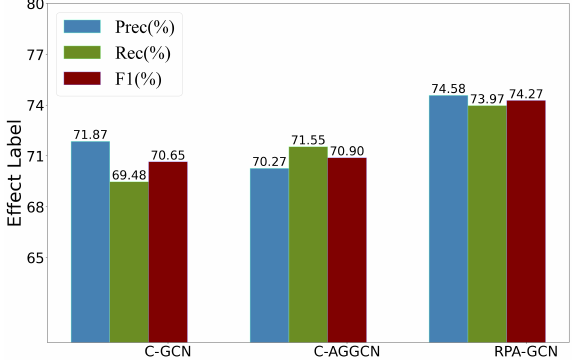
Figure 12. Value of precision, recall, and F1 of effect